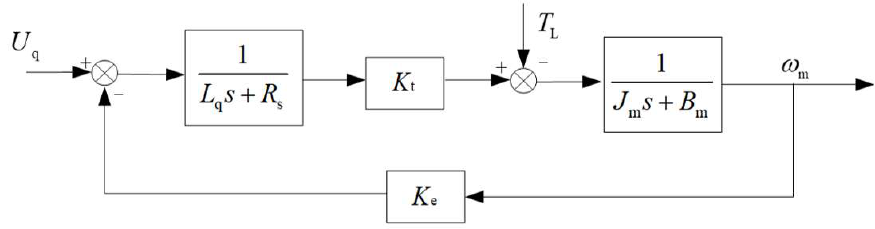
( b ) Figure 8. System current loop frequency characteristic curve. ( a ) Amplitude diagram. ( b ) The phase diagram. Figure 8 shows that after the dynamic analysis and parameter adjustment of the cur- rent loop, the bandwidth of the system’s current loop can reach 360 Hz. The current loop has a very strong response speed and can quickly track the instruction input signal.